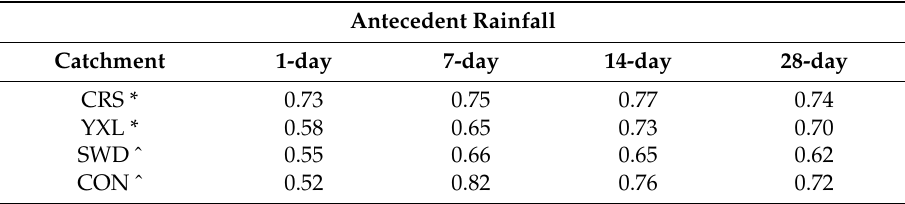
Table 3. Spearman’s rank order correlation coefficients for instantaneous discharge and antecedent rainfall